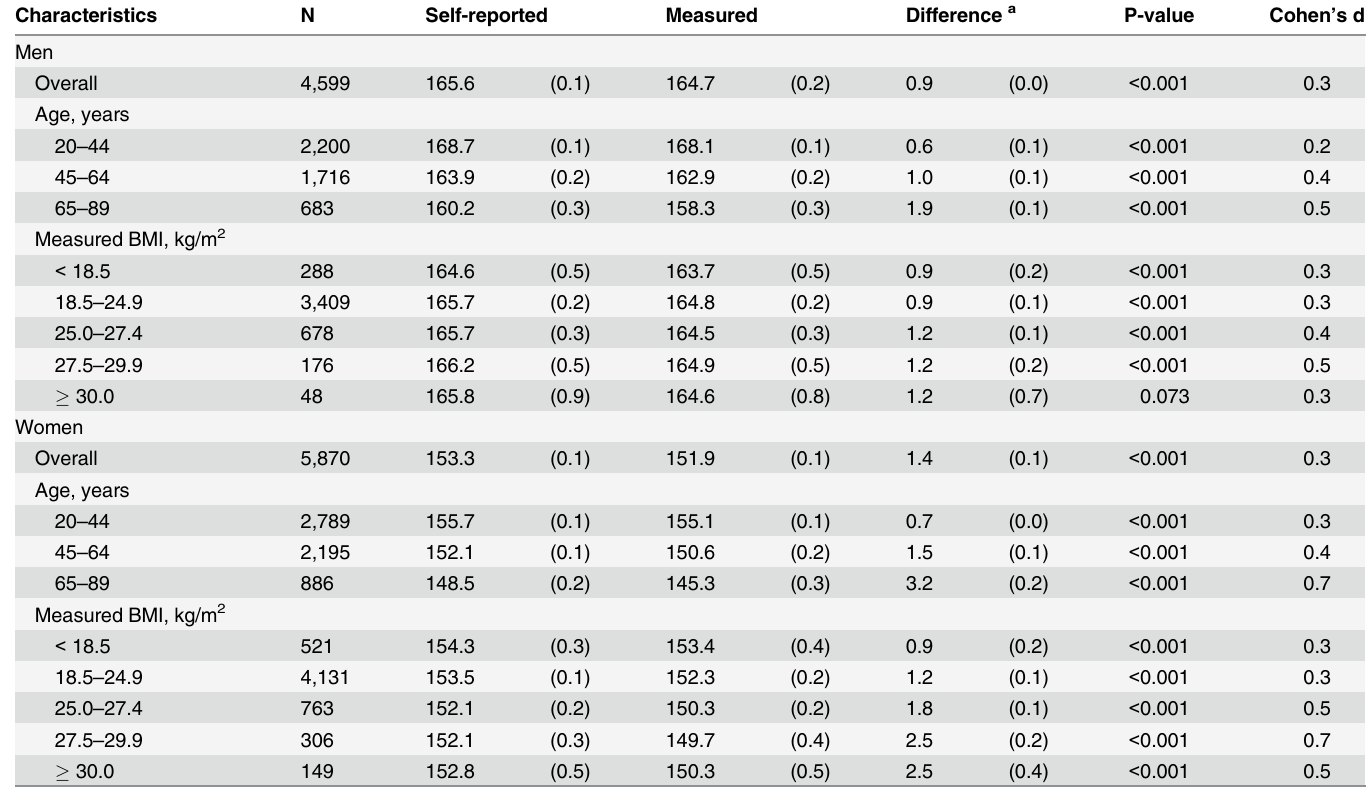
Table 1. Differences between self-reported and measured means of height by characteristics of participants based on the National Nutrition Sur- vey, 1986. Characteristics N Self-reported